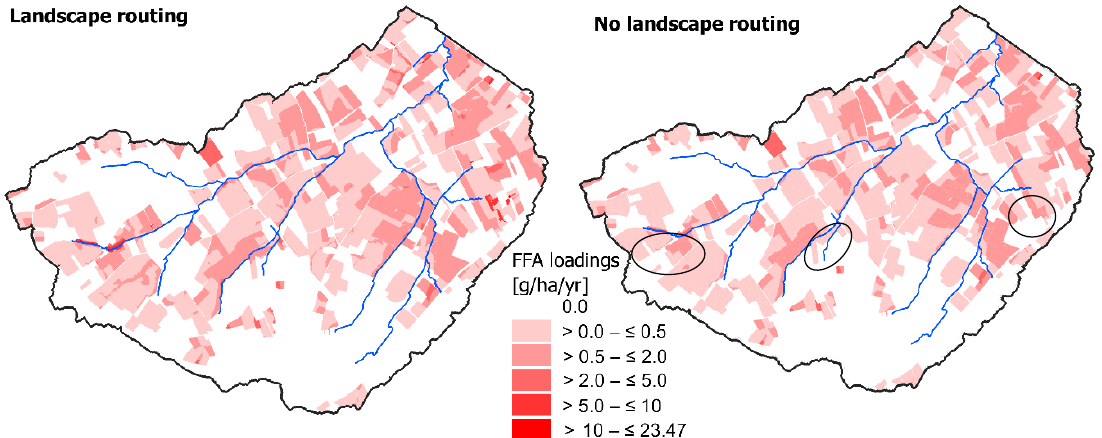
Figure 4. Spatial distribution of annual average HRU-level FFA loadings for the landscape routing (LR-FS) and no landscape routing (NR-FS) configuration; circles mark notable differences between the two configurations.